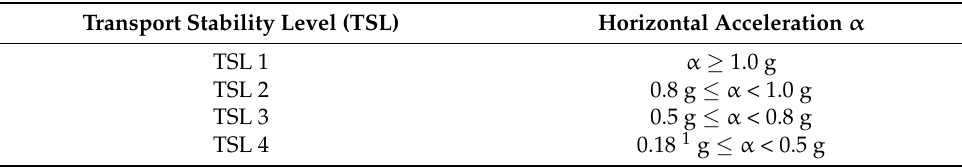
Table 1. Transport stability levels (TSL) for PUL (by authors based on